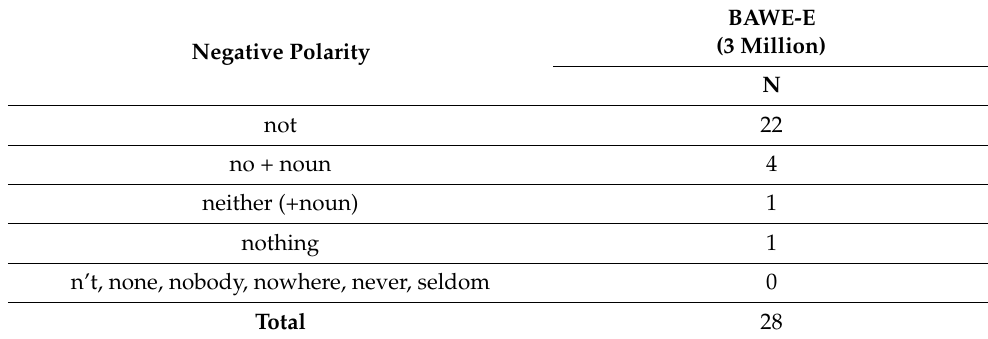
Table 1. Frequency of negative polarity associated with OTC in